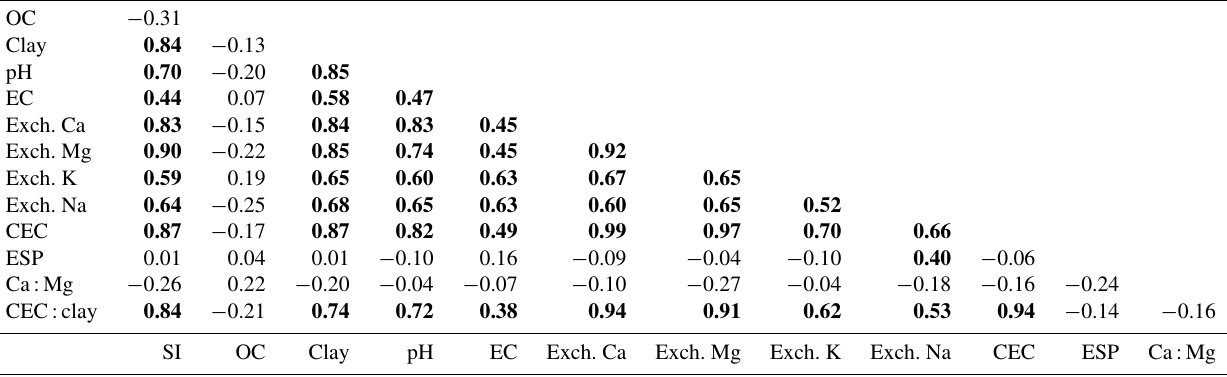
Table 4. Pearson correlation coefficient ( r ) between soil properties.